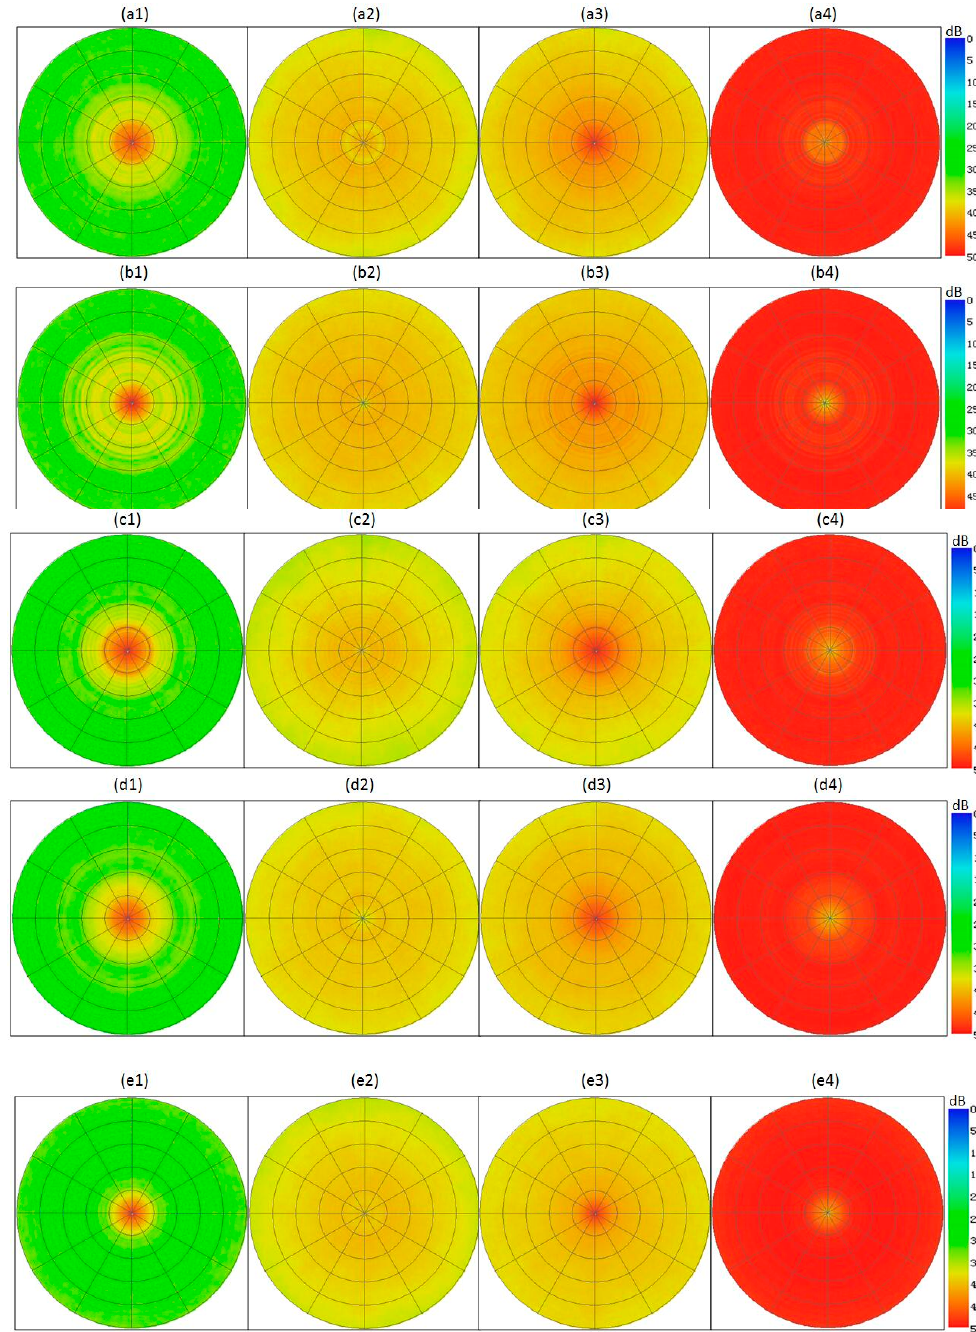
Figure 8. The statistical results of dBP CAT (the first column), dBP ME (the second column), dBP Z (the third column), and dBP MEZ (the fourth column) for Changping radar ( a1 – a4 ), Fangshan radar ( b1 – b4 ), Miyun radar ( c1 – c4 ), and Shunyi radar ( d1 – d4 ), Tongzhou radar ( e1 – e4 ),